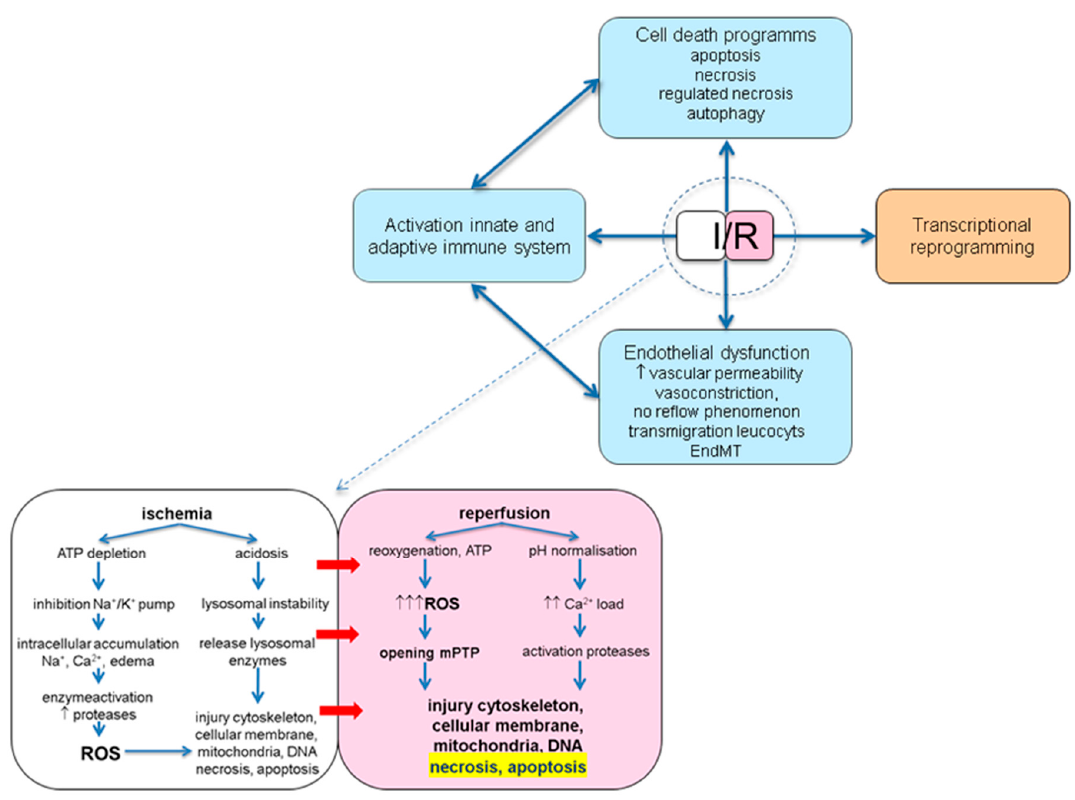
Figure 1. Schematic overview of the pathophysiological consequences of ischemia and reperfusion. I/R: ischemia/reperfusion; ATP: adenosine triphosphate; EndMT: endothelial to mesenchymal transition; ROS: reactive oxygen species; mPTP: mitochondrial permeability transition pore.